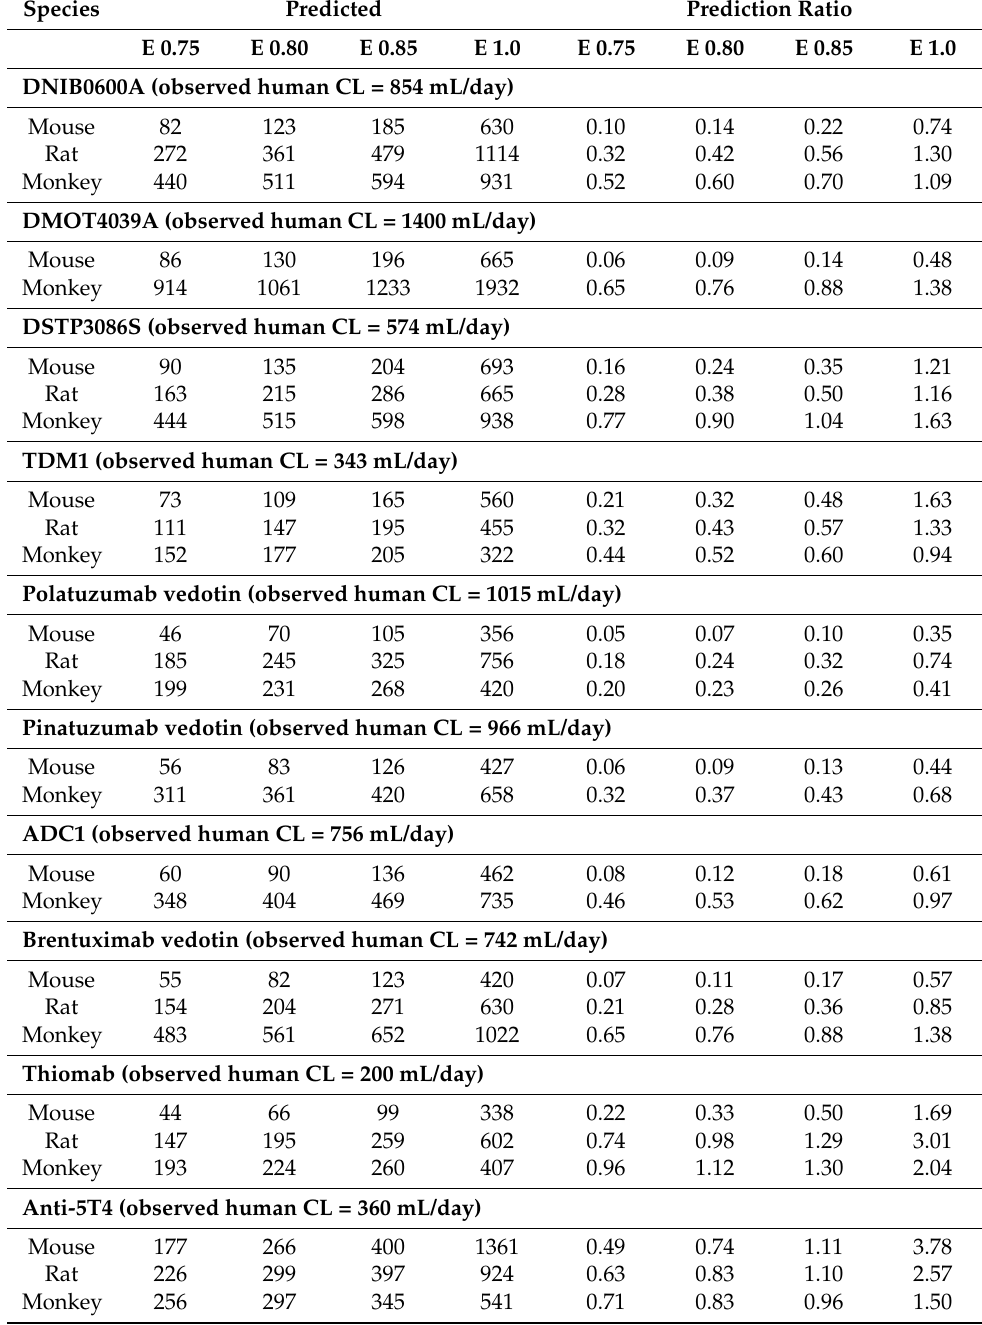
Table 5. Predicted human clearance (total antibody) by different exponents from mouse, rat, and monkey.